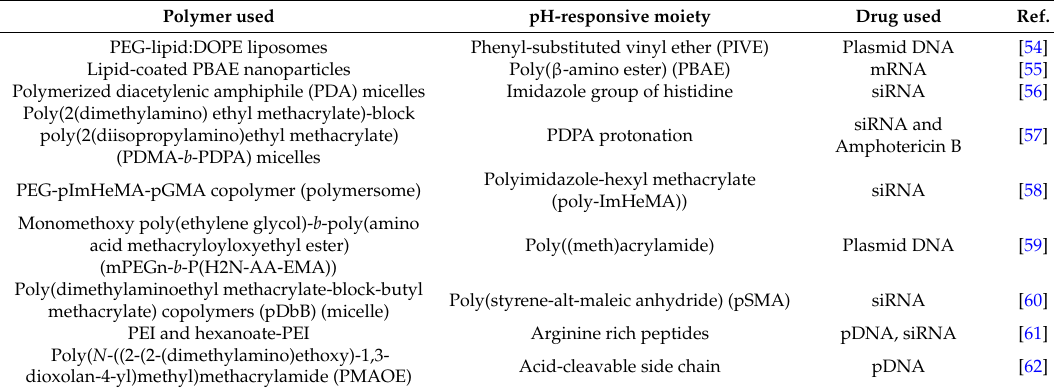
Table 1. pH-sensitive delivery systems for therapeutic gene